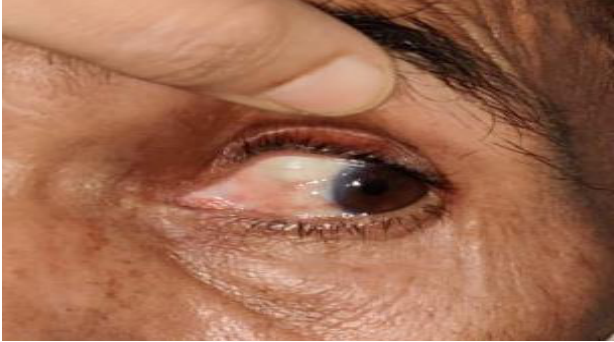
Fig. 8. Completely healed lesion with vascularized conjunctiva after 4